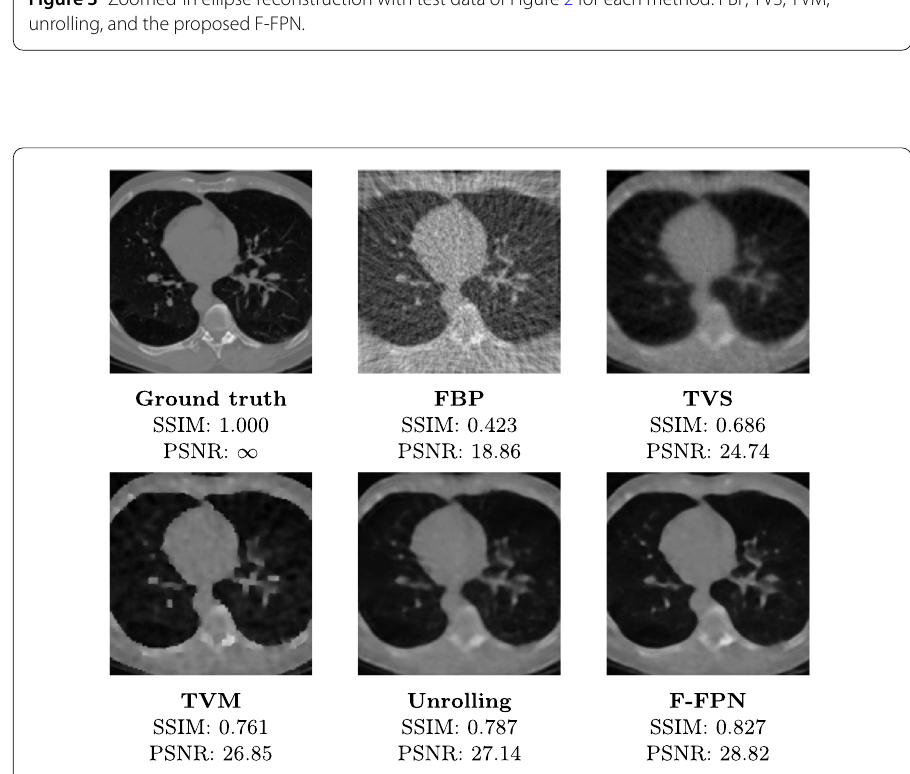
Figure 4 LoDoPab reconstruction with test data for each method: filtered back projection (FBP), TV superiorization (TVS), TV minimization (TVM), unrolled network, and the proposed feasibility-based fixed point network